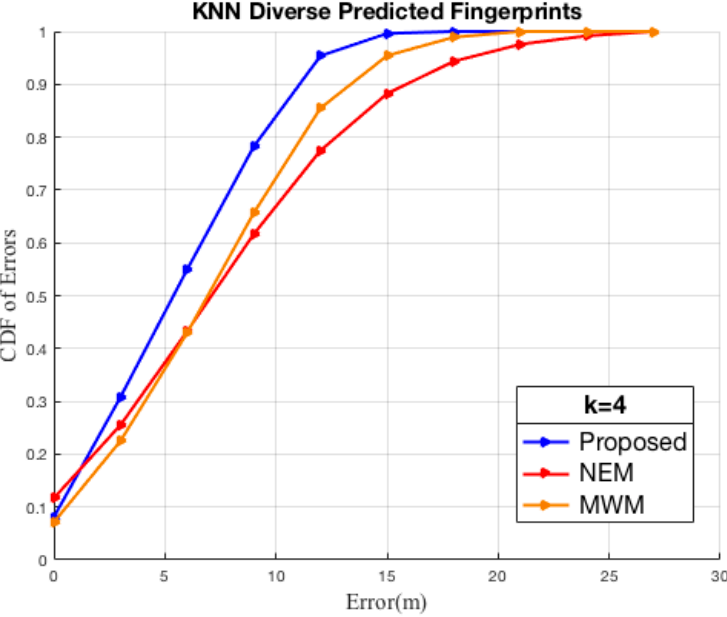
Figure 9. Localization. KNN Comparison by diverse predicted fingerprints. Table 16. KNN with diverse fingerprints.